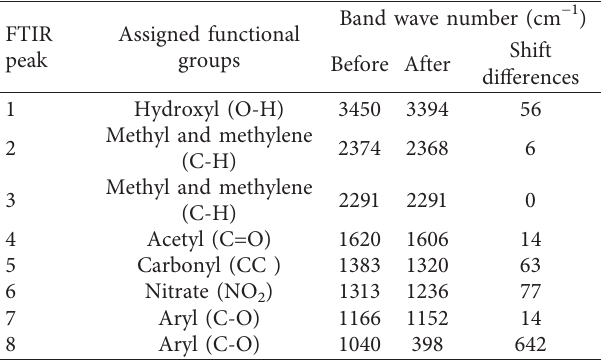
Table 3: FTIR spectral characteristics of CISAC before and after Pb (II) ion adsorption.